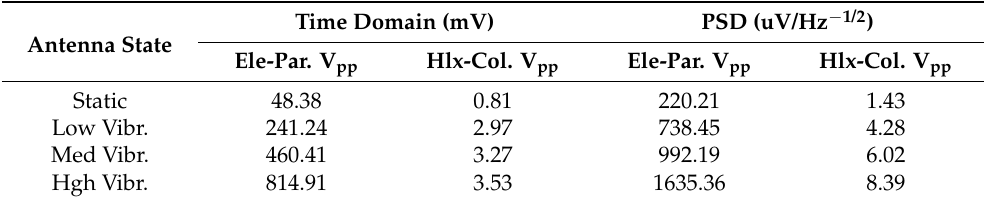
Table 2. Experimental results of signal and noise varying with various vibrations.